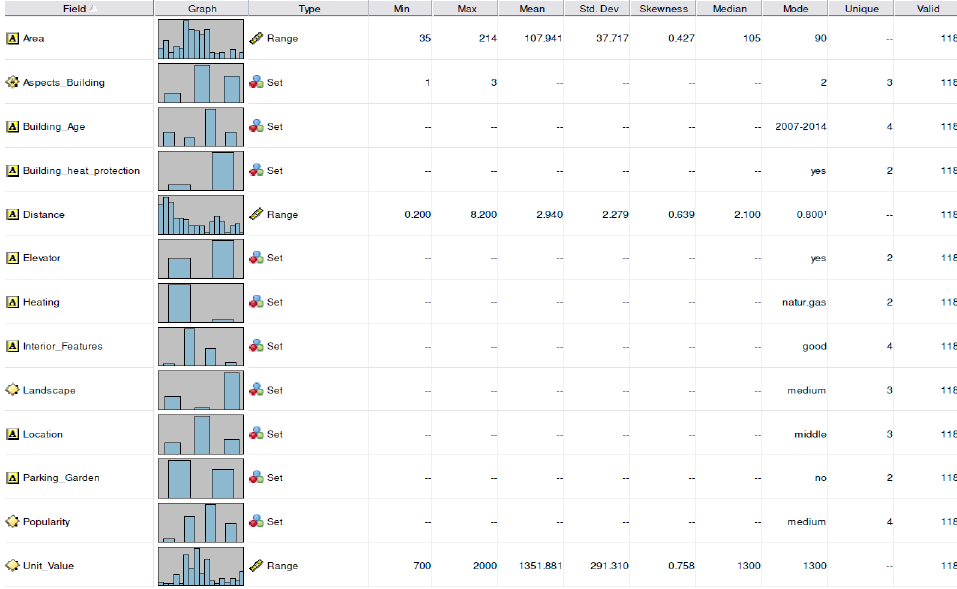
Fig. 2. Descriptive statistics and distribution of data using the data mining package program (developed by the